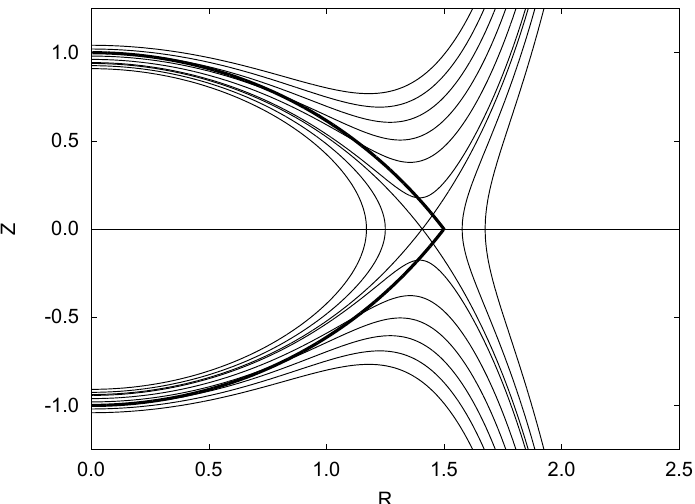
Figure 13. The shape of the star surface at ω = 1 (thick solid line) and lines of the constant values of the effective potential ϕ (thin lines) at ω =